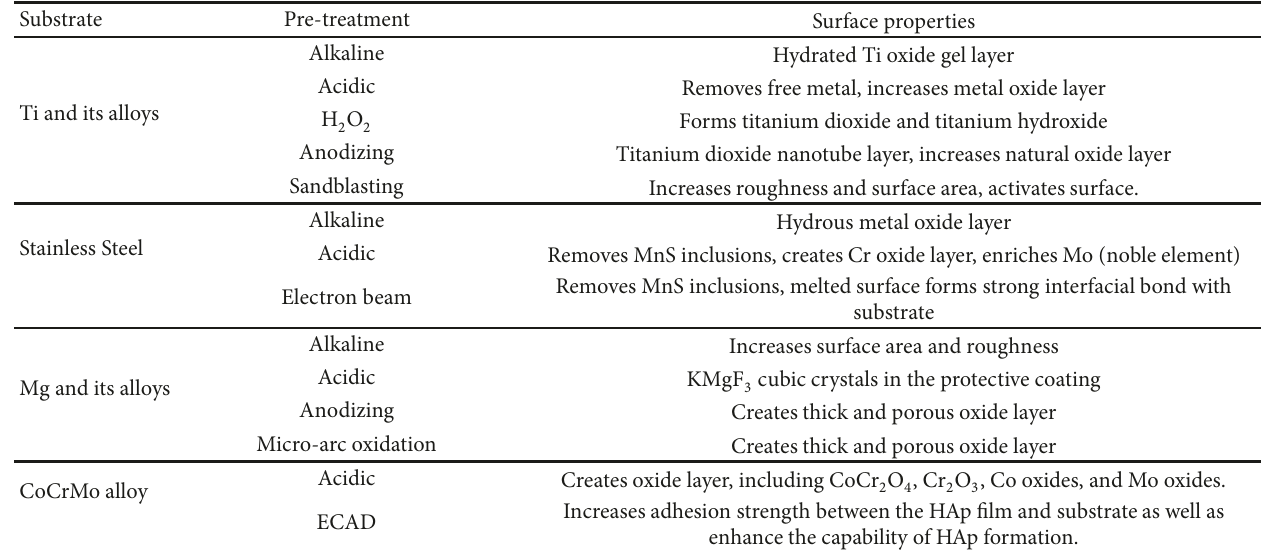
Table 6: Summary of pretreatments and results for different biocompatible